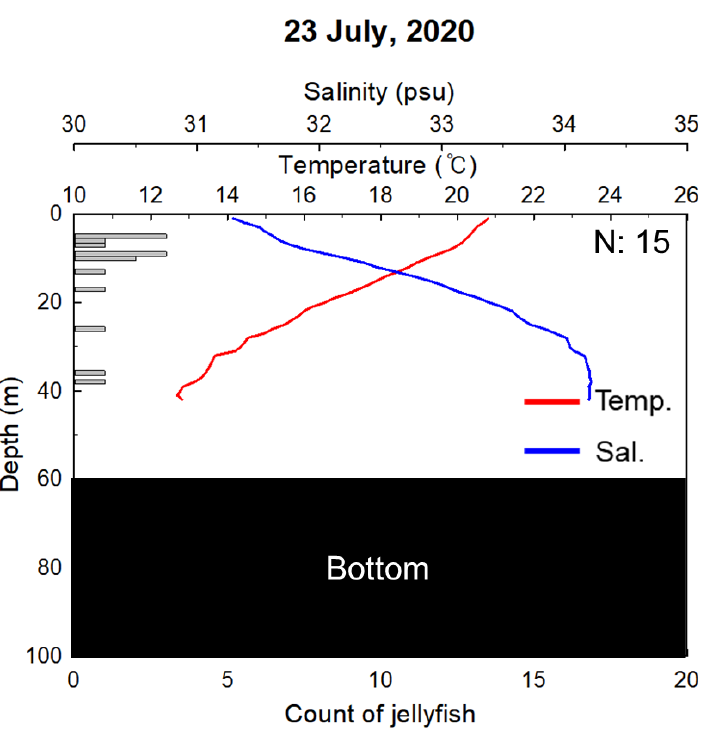
Figure 22. Distribution by water layers in the Gijang coastal waters sea (23 July, 2020). Table 14. Distribution density of jellyfish using the echo counting method in the Gijang coastal wa- ters sea (7/23).